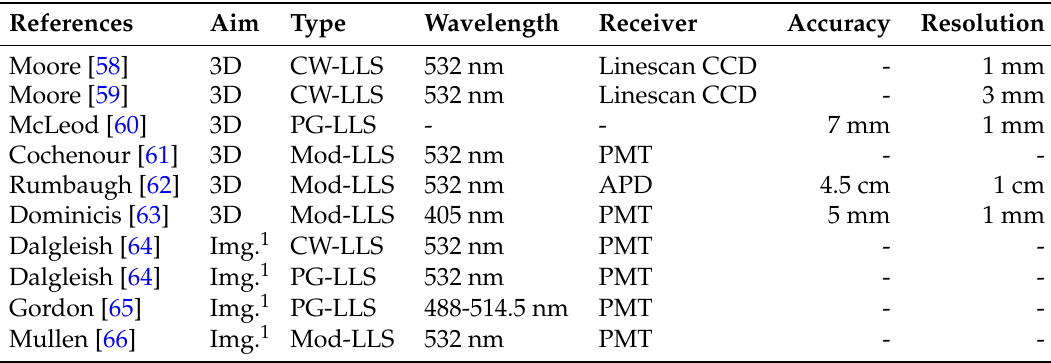
Table 3. Summary of laser line scanning 3D reconstruction